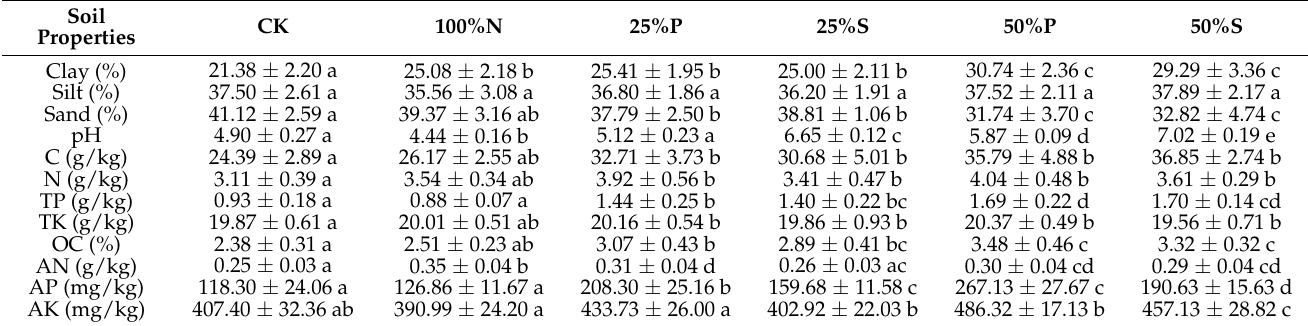
Table 1. Soil properties in different experimental plots (mean ± standard deviation, n =